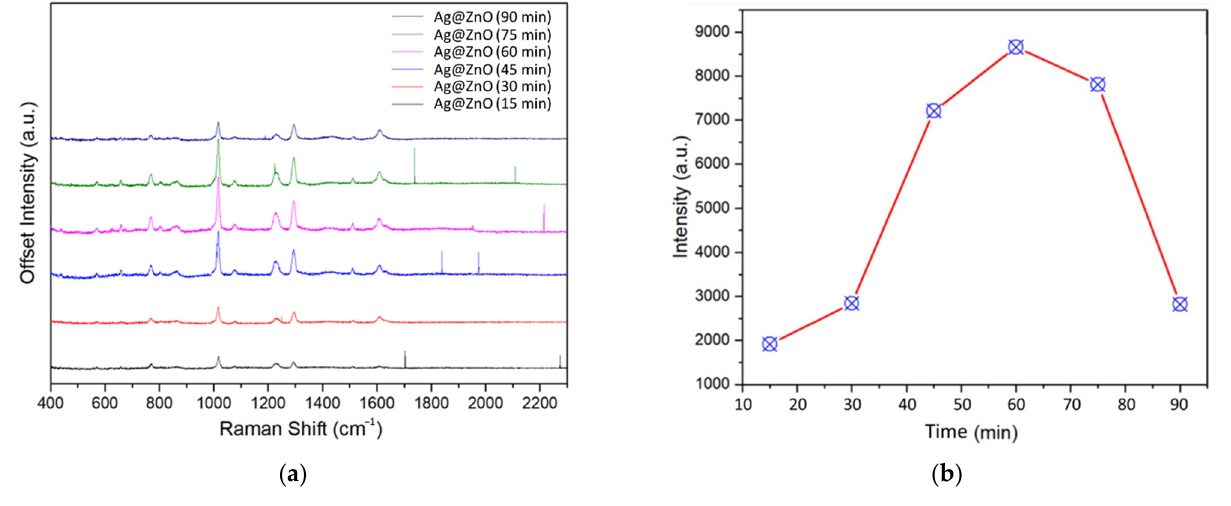
Figure 5. ( a ) SERS of DPY adsorbed on Ag@ZnO-ITO synthesized at various irradiation times. ( b ) Raman intensity of peak at 1298 cm − 1 of DPY adsorbed on Ag@ZnO-ITO at various irradiation times.